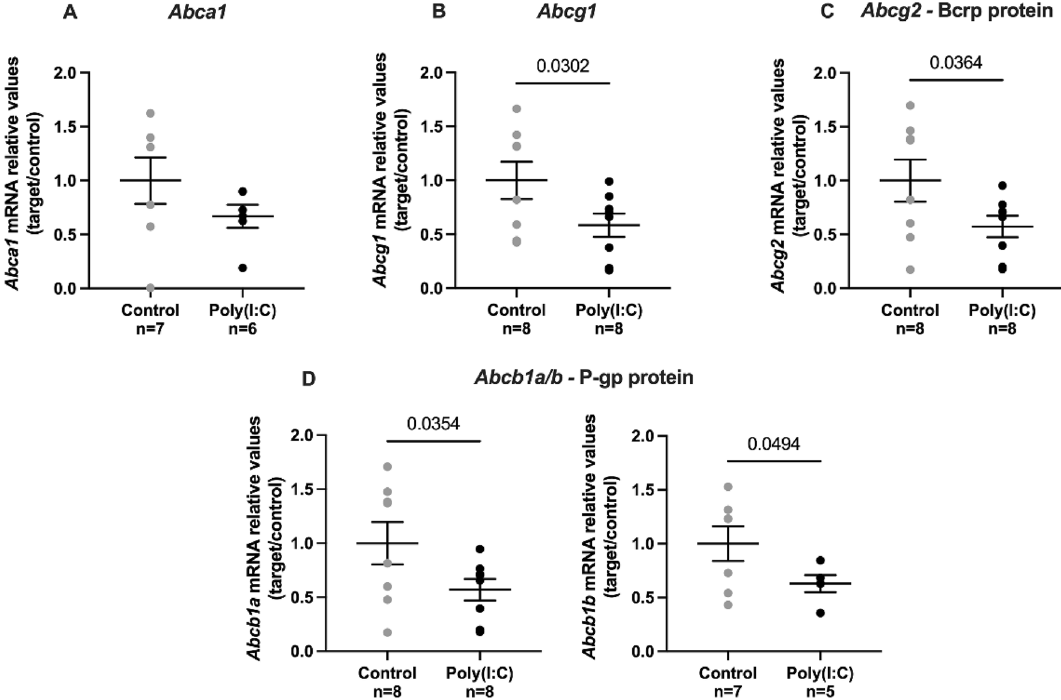
Figure 3. Mid-pregnancy poly(I:C) administration decreases Abcb1a/b , Abcg1 and Abcg2 mRNA expression in the placenta at GD18.5. ( A ) Abca1 , ( B ) Abcg1 , ( C ) Abcg2 and ( D ) Abcb1a/b relative gene expression. When n < 8, samples did not pass quality checks of LinReg software and were removed from the analysis. Values are expressed as mean ± SD. Student’s t-test was